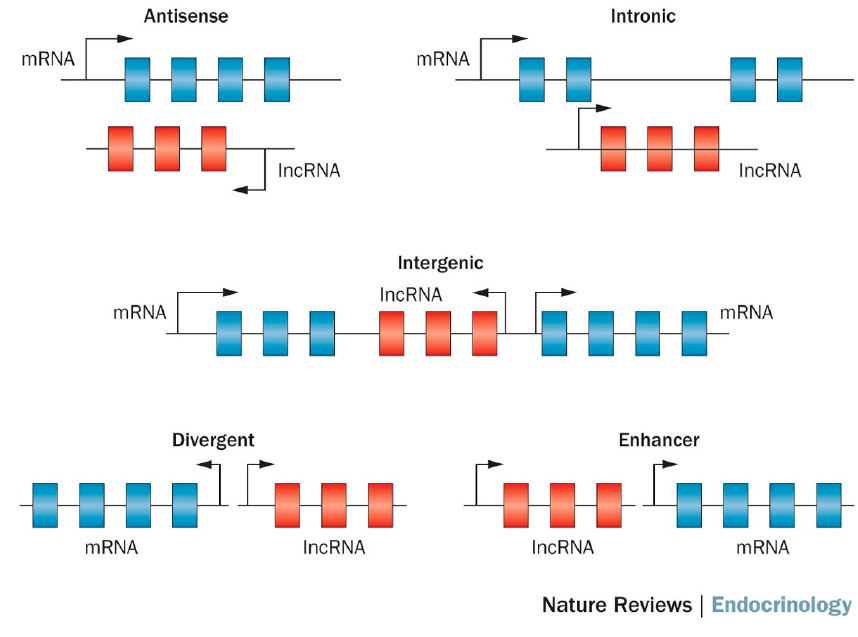
Figure 1. Biogenesis of long non-coding RNA (lncRNA) [10]. Genes 2017 , 8 , 366